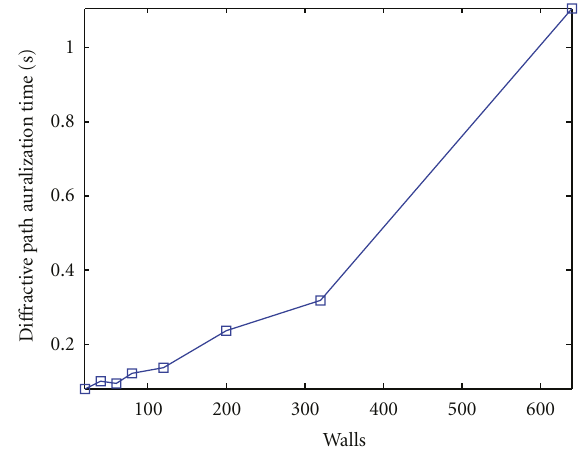
Figure 16: Auralization time for di ff ractive paths (measured in seconds) versus the complexity (measured by the number of walls) of the